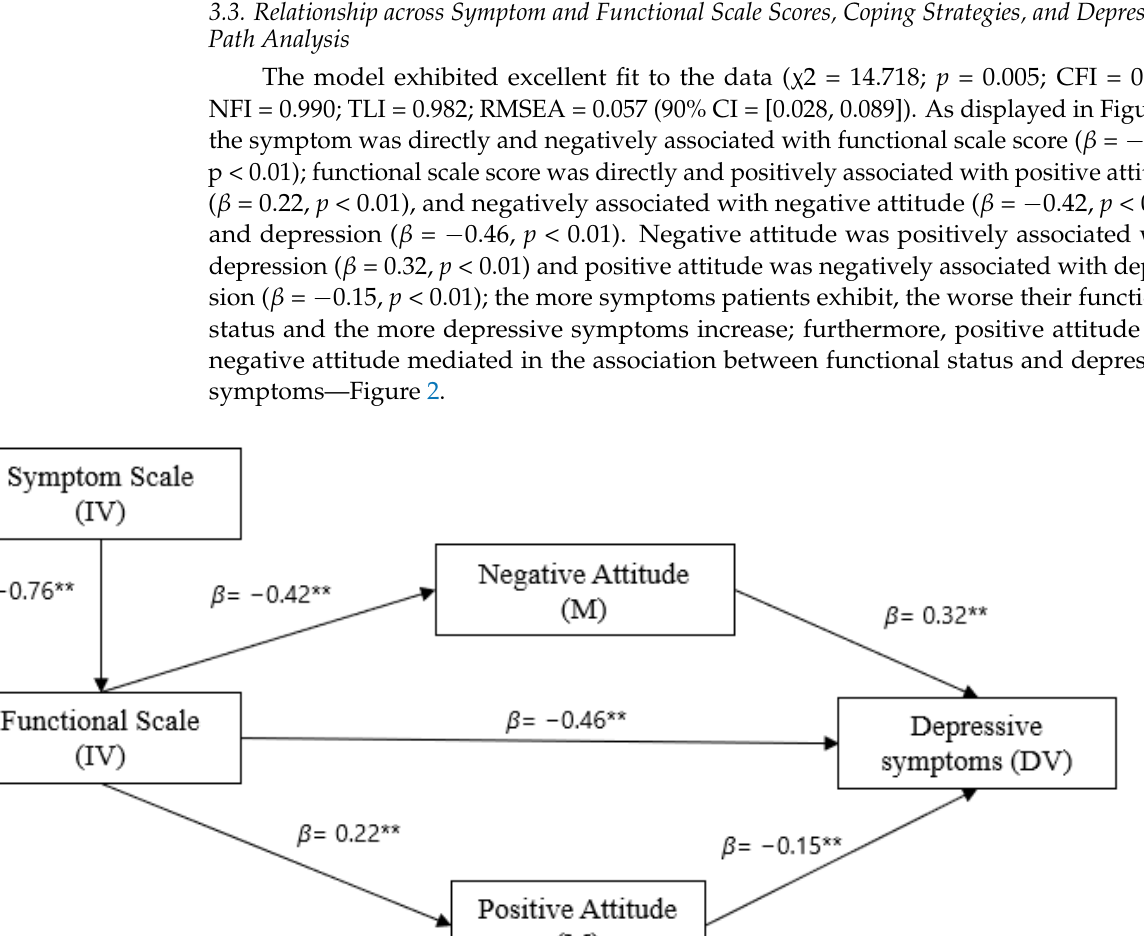
Figure 2. Predictive model of depressive symptoms among patients with advanced cancer. Lines present the significant pathways. ** p < 0.001.